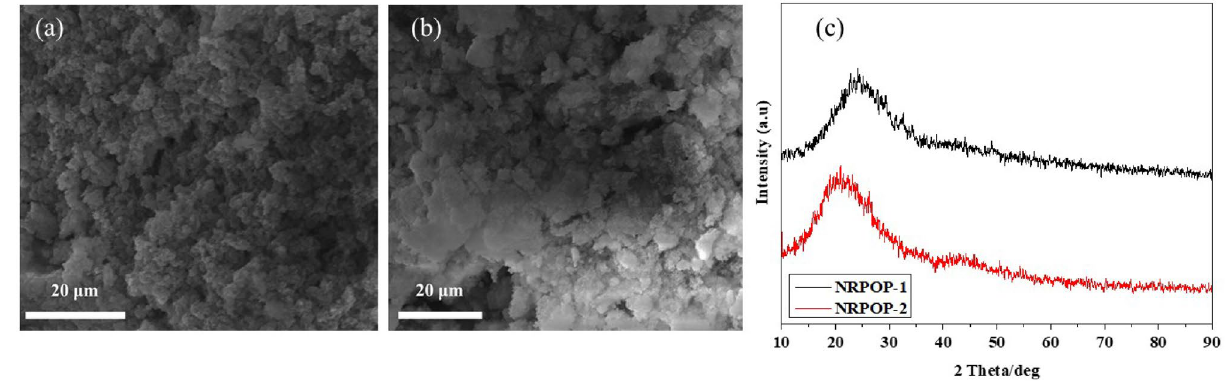
Figure 2. SEM images of NRPOP-1 ( a ) and NRPOP-2 ( b ) and their respective PXRD patterns ( c ).